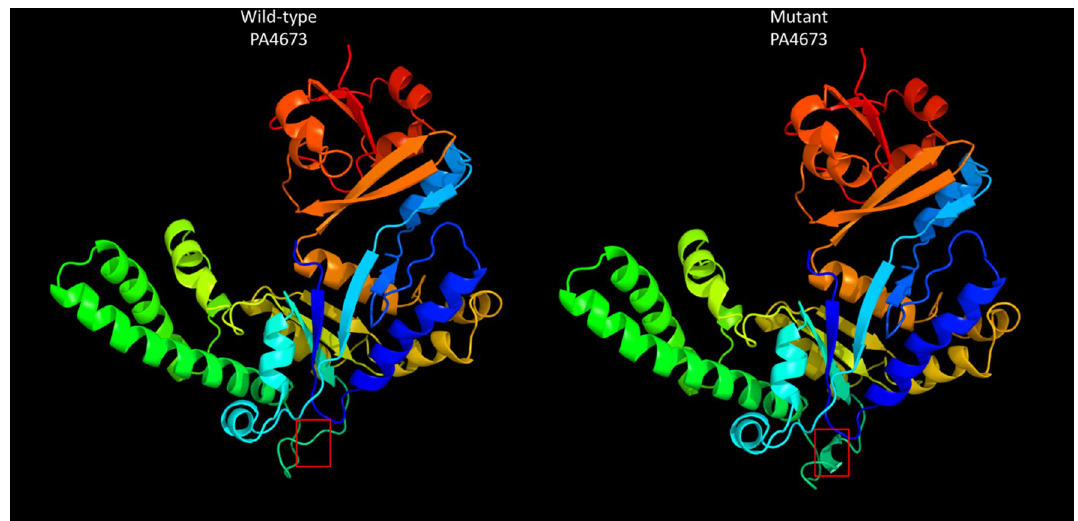
Figure 2. Protein structure of wild-type and mutant PA4673. Protein structures were derived from the amino acid sequences of wild-type and mutant PA4673 using Phyre2. The red box indicates the structural change caused by the SNP. Functional domain identification in both PA4673 isoforms indicates that they likely function as GTP-binding proteins. As the SNP causes an amino acid change in the exterior portion of the predicted protein structure, it may lead to alteration of a binding site or protein